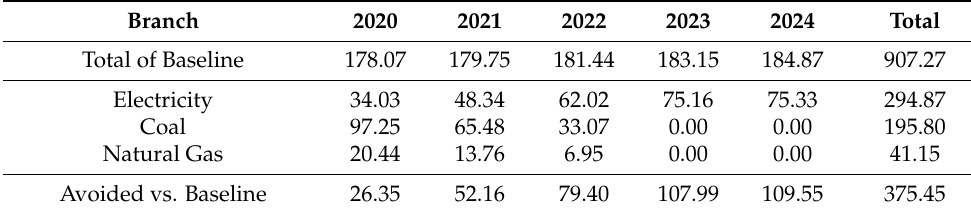
Table 7. Table of boiler module carbon emissions between BR and baseline scenarios.